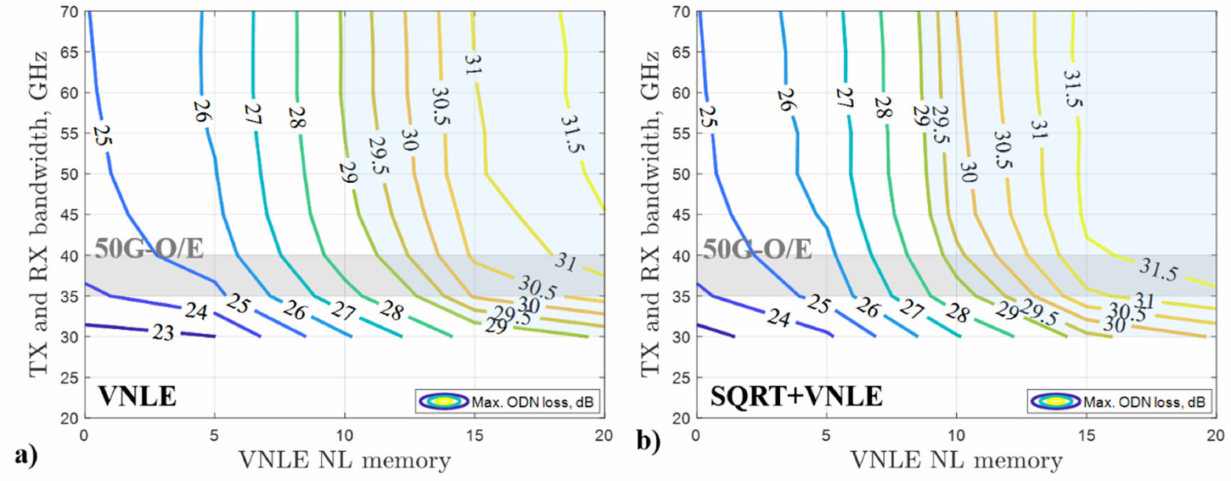
Figure 6. Maximum ODN loss at BER T = 10 − 2 as a function of TX/RX bandwidth and nonlinear memory of VLNE. The fiber length is L = 20 km: ( a ) VNLE; and ( b ) SQRT + VNLE. The light blue area is where ODN loss is above 29 dB, and the light grey area is where commercial 50G-O/E are considered. The VNLE NL memory = 0 is equivalent to RX DSP option SQRT + FFE + DFE. TOP is 11 dBm for SQRT + FFE + DFE and 15 dBm for all other RX DSP